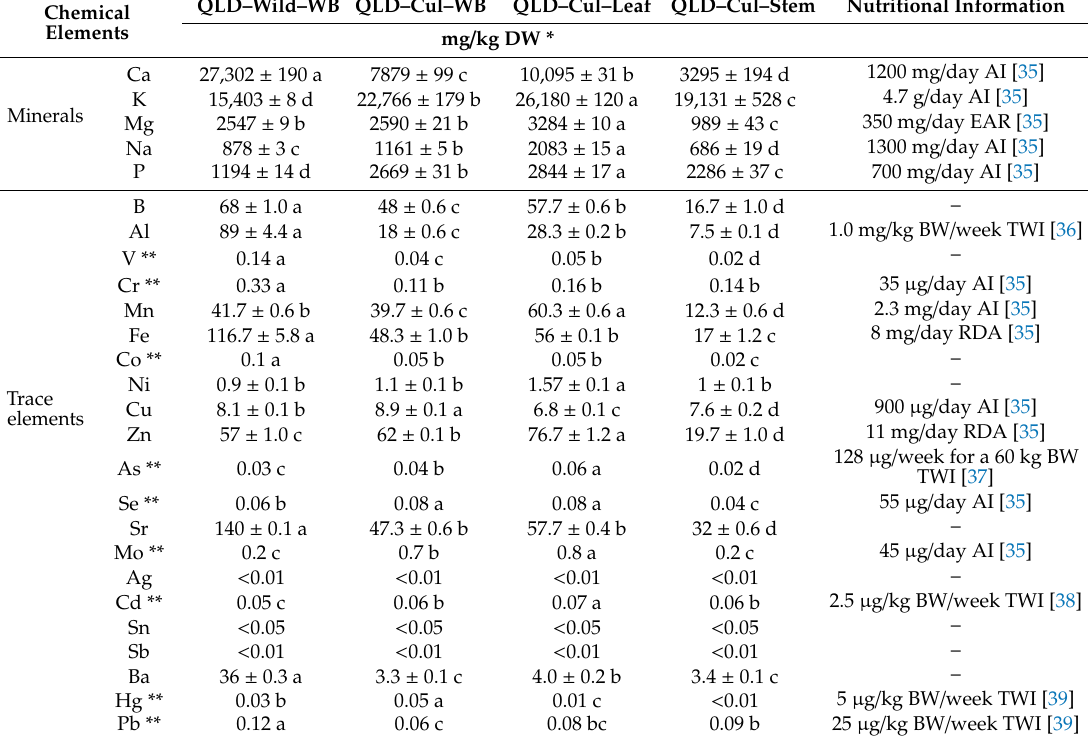
Table 2. Minerals and trace elements of di ff erent P. angustifolium samples collected in